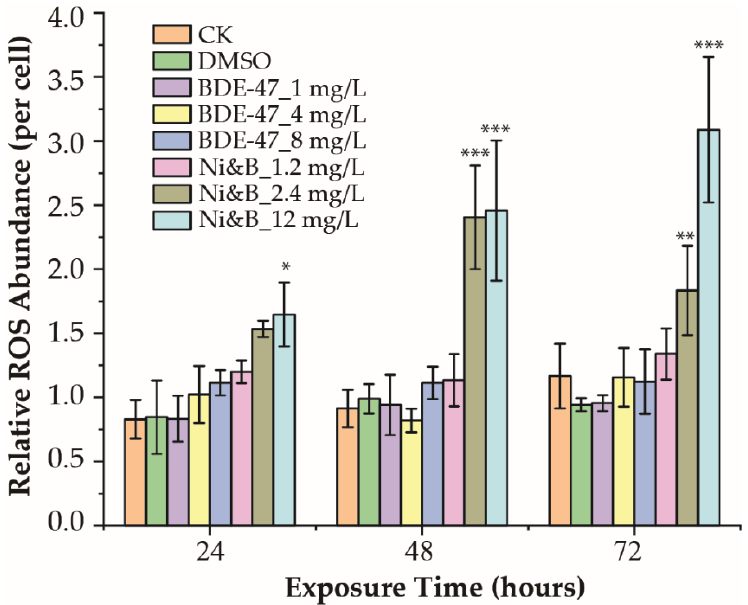
Figure 3. Relative ROS production of P. tricornutum after individual BDE-47 treatment and treatment with mixtures of BDE-47/nickel. *** p < 0.001; ** p < 0.01, and * p < 0.05. Error bars indicate ± SD. p -values are shown in Table S5.